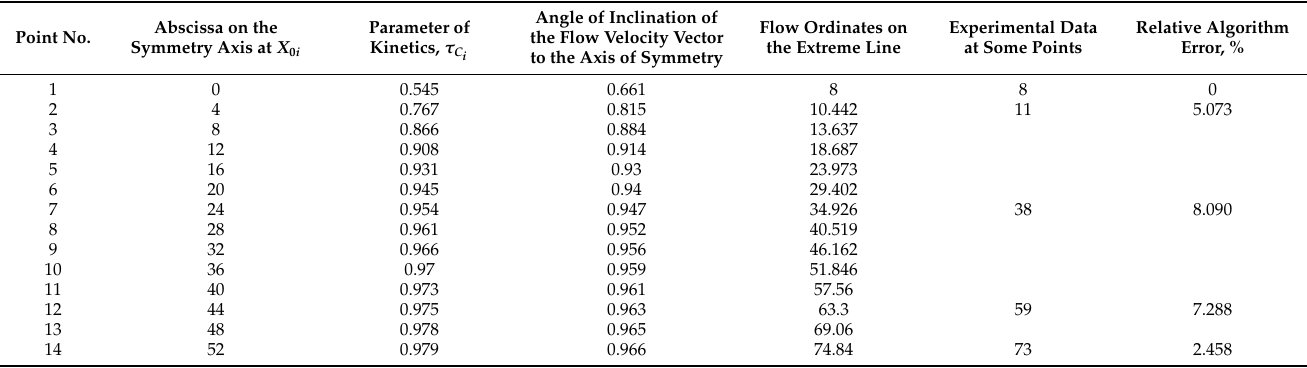
Table 2. Calculation of extreme line flow point ordinates and comparison with experimental data. Point No. Relative Algorithm Error,